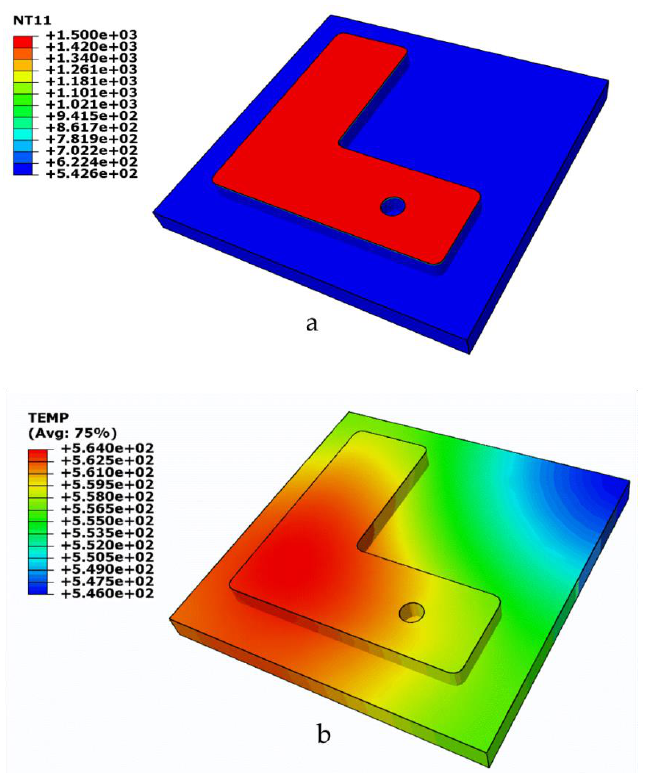
Figure 4. Temperature distribution (K) at various stages during printing: ( a ) when a new layer is activated, ( b ) just before a new layer is added.